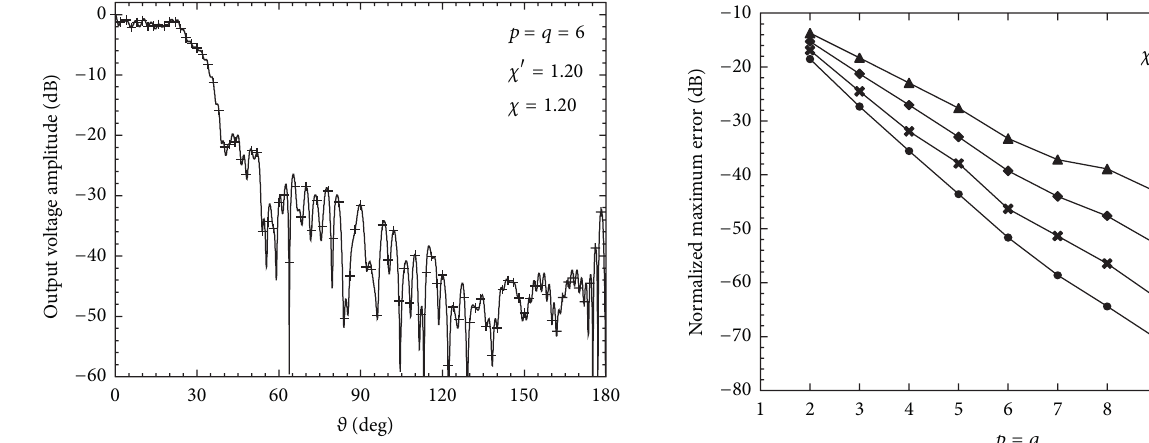
Figure 8: Amplitude of the probe voltage 𝑉 on the meridian at 𝜑 = 0 ∘ . Solid line: exact. Crosses: interpolated.